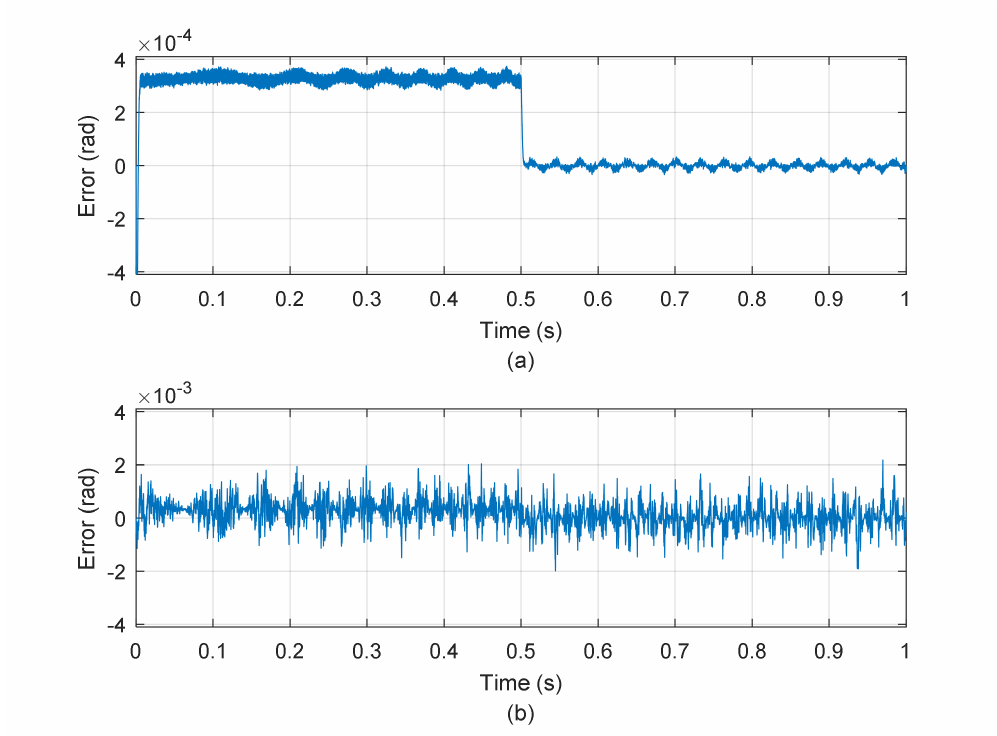
Figure 16. Experimental results for N p = 120, N c = 2, R w = 0.01. ( a ) Without noise; ( b ) with noise.